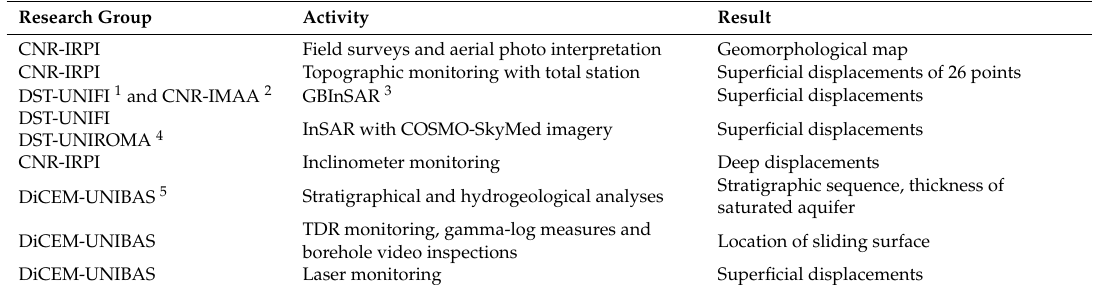
Table 1. Summary of surveys and monitoring activities carried out on the Montescaglioso landslide.